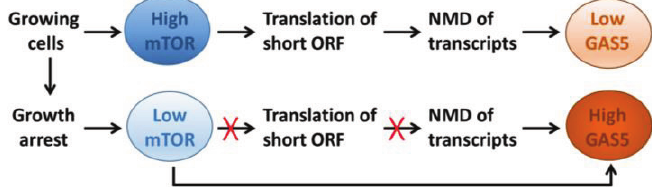
Figure 2. Interplay between mammalian target of rapamycin (mTOR) and nonsense- mediated decay (NMD) regulates cellular GAS5 lncRNA